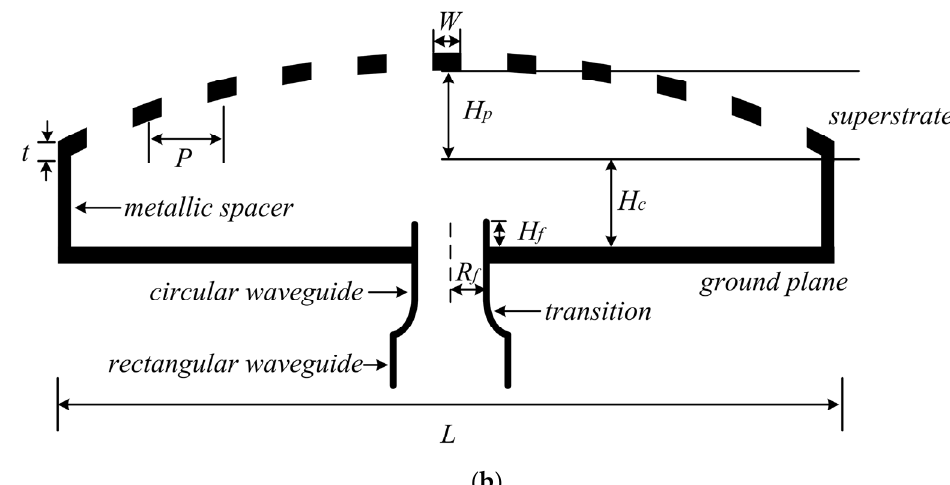
Figure 2. Configuration of the proposed FPRA. ( a ) 3-D view; ( b ) cross-section view with main structural parameters.